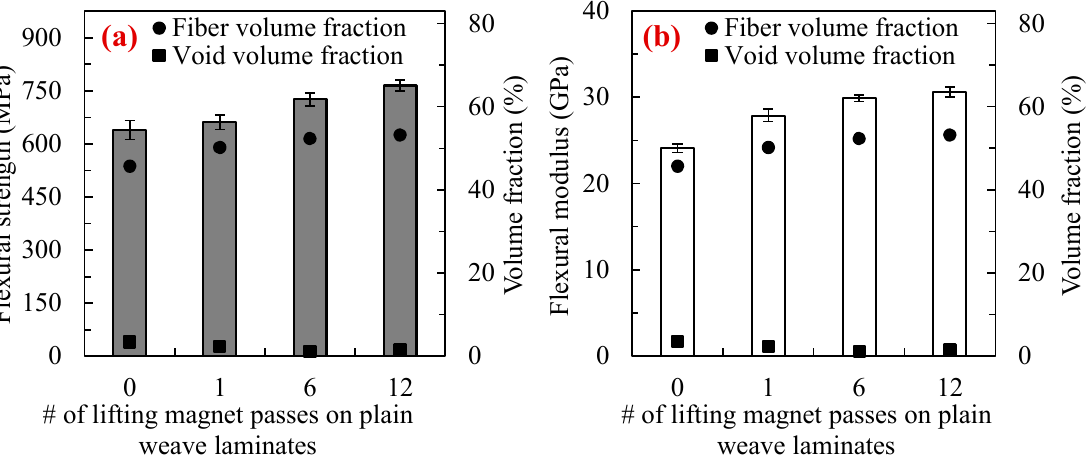
Figure 10. ( a ) Flexural strength and ( b ) modulus of plain weave laminates fabricated with WLVB and increasing number of passes of a lifting magnet (i.e., 0, 1, 6, and 12 passes). Void and fiber volume fraction values are also presented. Note: Error bars show the 95% confidence interval ( n = 14 samples).